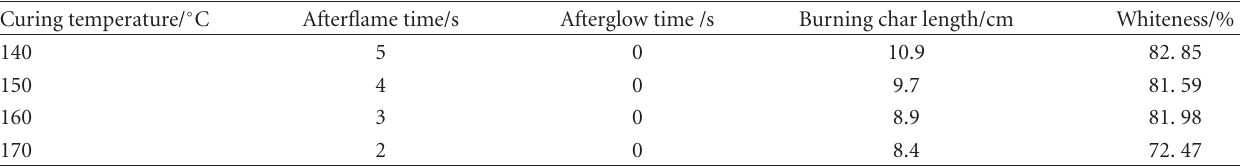
Table 6: E ff ect of the curing temperature on the fire-retardant performance